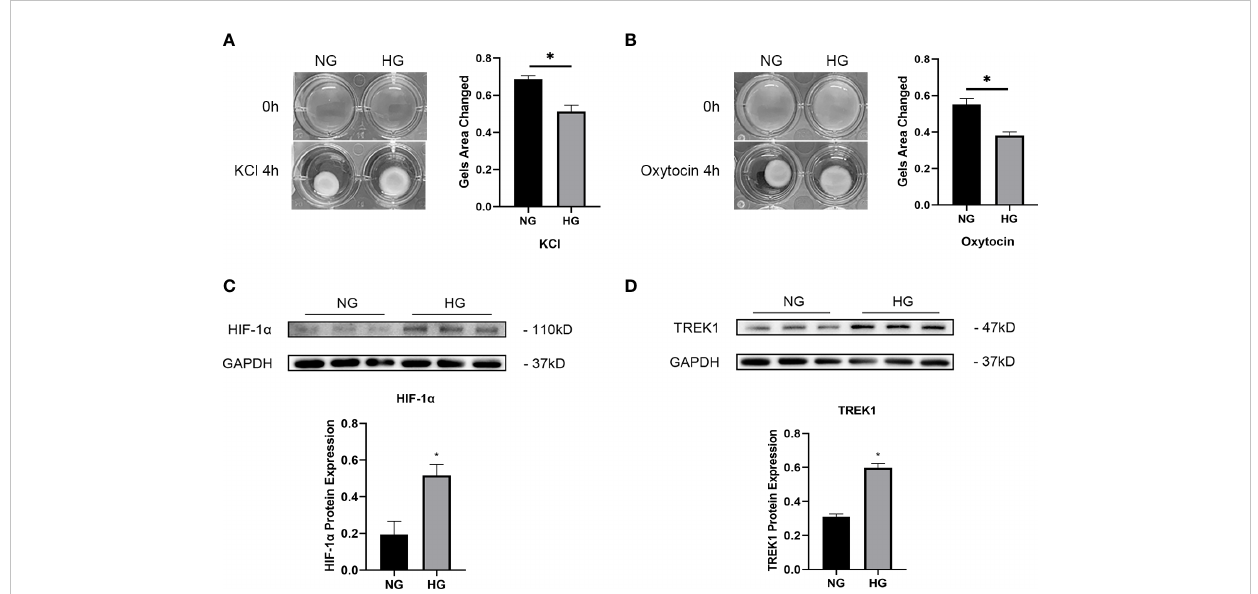
FIGURE 3 High glucose level decreased cell contraction and increased protein expression of HIF-1 a and TREK1 in HUSMCs. HUSMCs mixed with collagen were cultured in normal glucose (5.5 mmol/L) (NG) medium and high glucose (25 mmol/L) (HG) medium in a 24-well culture plate. The medium was added after collagen polymerization (0 h). The images of collagen stimulated by KCl (A) or oxytocin (B) for 4 h. The contraction of HUSMCs was assessed by measuring the mean gel area change ([the area of KCl 4 h – the area of 0 h]/the area of 0 h and [the area of oxytocin 4 h – the area of 0 h]/the area of 0 h). The HUSMCs of each group were cultured in NG medium at the beginning, and the HG group was replaced with HG medium for 24 h when the cell density reached 60% – 70%. Then, the total protein of each group was extracted, and HIF-1 a (C) and TREK1 (D) protein expression was measured by western blot analysis. Three or four independent experiments were conducted, and the average of each group was calculated. Data are presented as means ± SEM, n = 4 for each group. * means HG vs. NG and P<0.05. HIF-1 a , hypoxia-inducible factor-1 alpha; HUSMCs, human uterine smooth muscle cells; SEM, standard error of the mean; TREK1, TWIK-1-related potassium